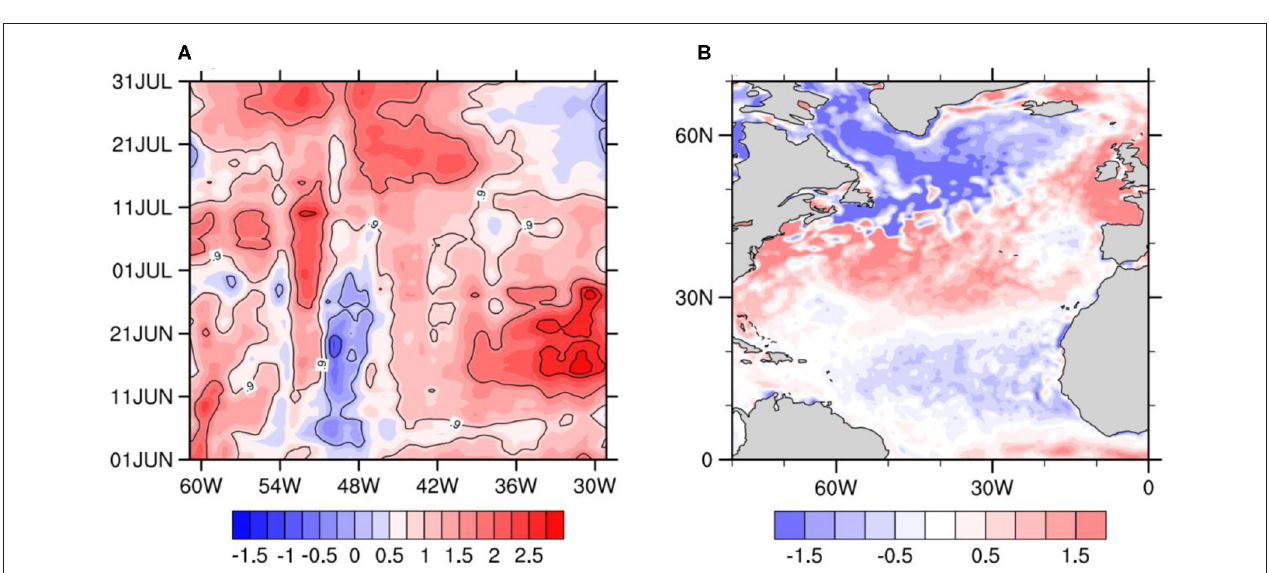
FIGURE 11 | (A) Longitude-time section of SSTA (32.5 ◦ N-42.5 ◦ N averaged); (B) SSTA in North Atlantic in the previous period (01 July-15 July).